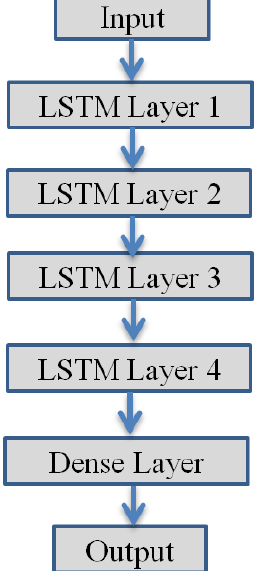
Figure 4. Proposed LSRM network architecture.